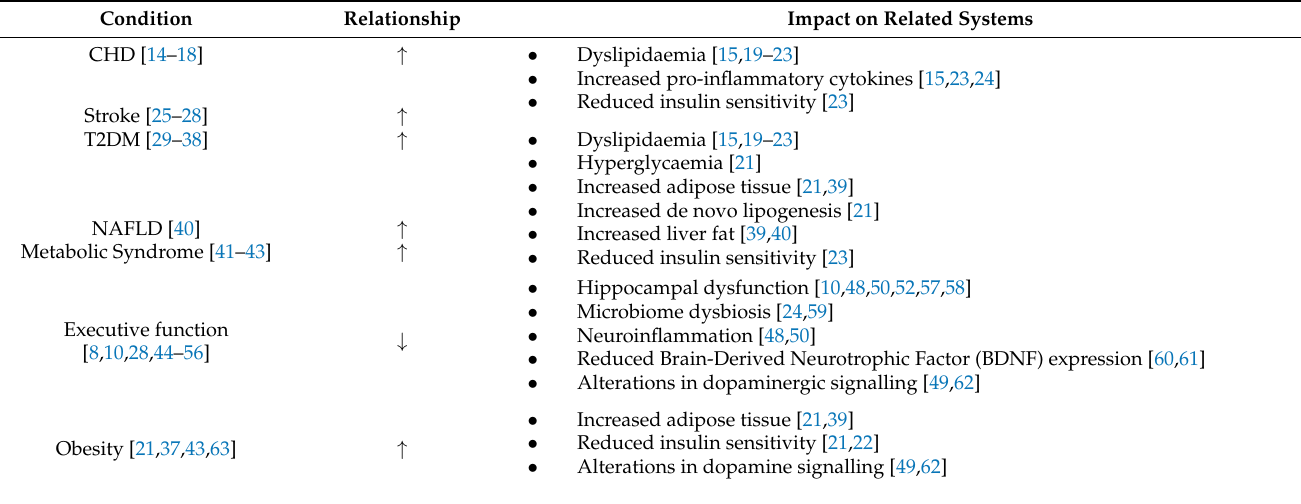
Table 1. Summary of findings outlining the effects of added sugar